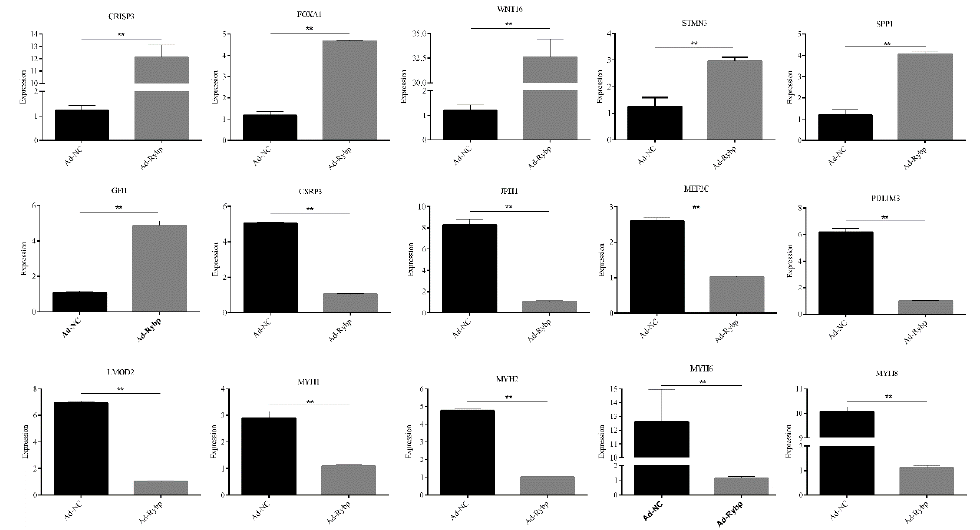
Figure 5. qRT-PCR validation of relative expression levels of representative DEGs. The measured RNA expression levels were normalized by GAPDH. Average values of three replicates are given with the mean ± SD ( n = 3) (** p < 0.01).